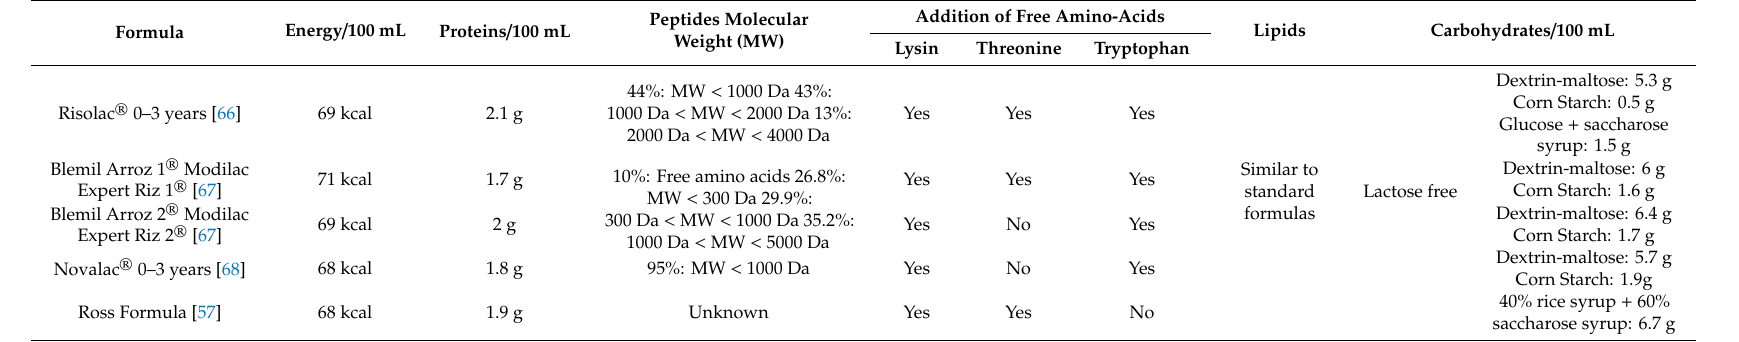
Table 3. Energy, protein, lipid, and carbohydrate content of